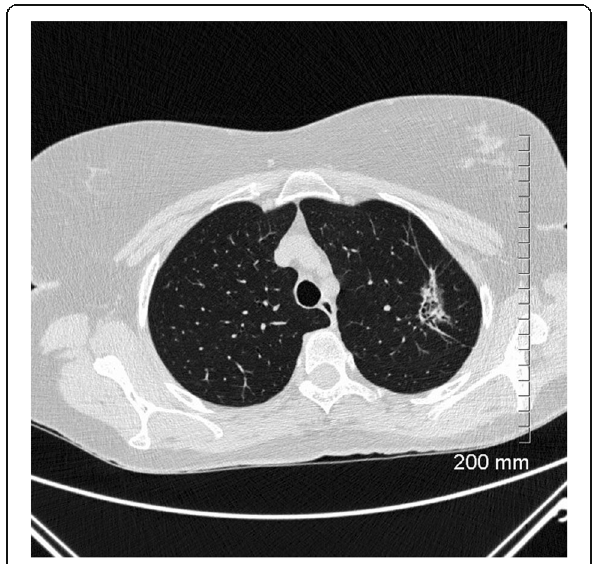
Fig. 17 Unfavourable prognostic indicators: concave notch. The solid, lobulated subpleural mass in the right lower lobe has a concave cut or notch on its medial border. Lepidic predominant